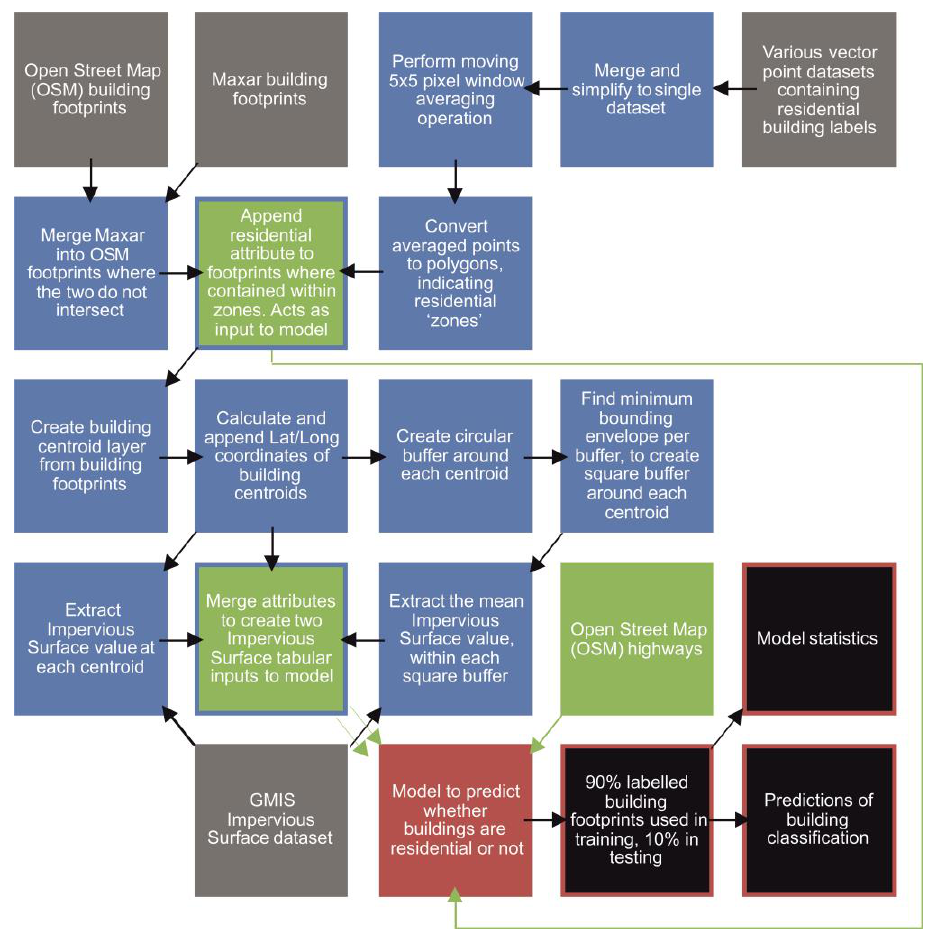
Figure 2. Flow diagram of GIS workflow, including how outputs integrate into the building classification model. Input datasets to the workflow are denoted in grey, with GIS workflow processes shown in blue. Inputs to the model are shown in green, and are depicted with blue outlines if also outputs from a GIS workflow process. The model is denoted in red, with model outputs and associated processes, respectively, shown in black with red outlines.